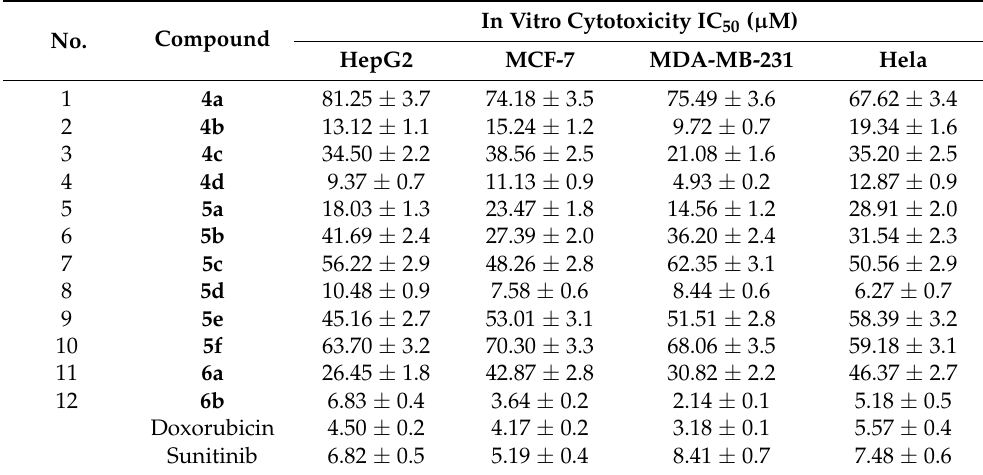
Table 2. IC 50 values ( µ M) of the synthesized compounds against the HepG2, MCF-7, MDA-MB-231, and HeLa cell